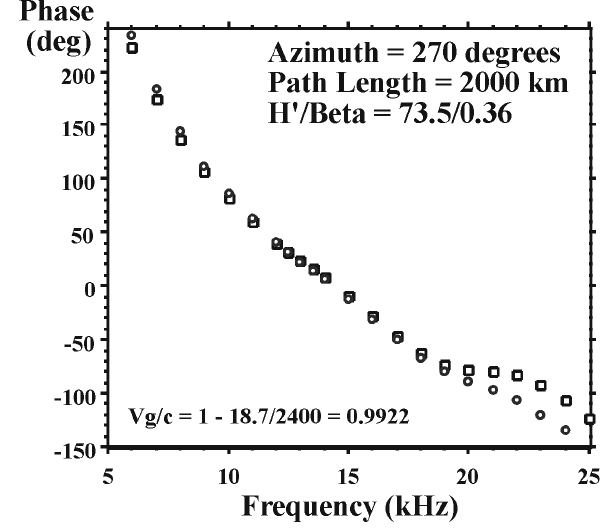
Fig. 10. As Fig. 9 but for propagation in the direction east to